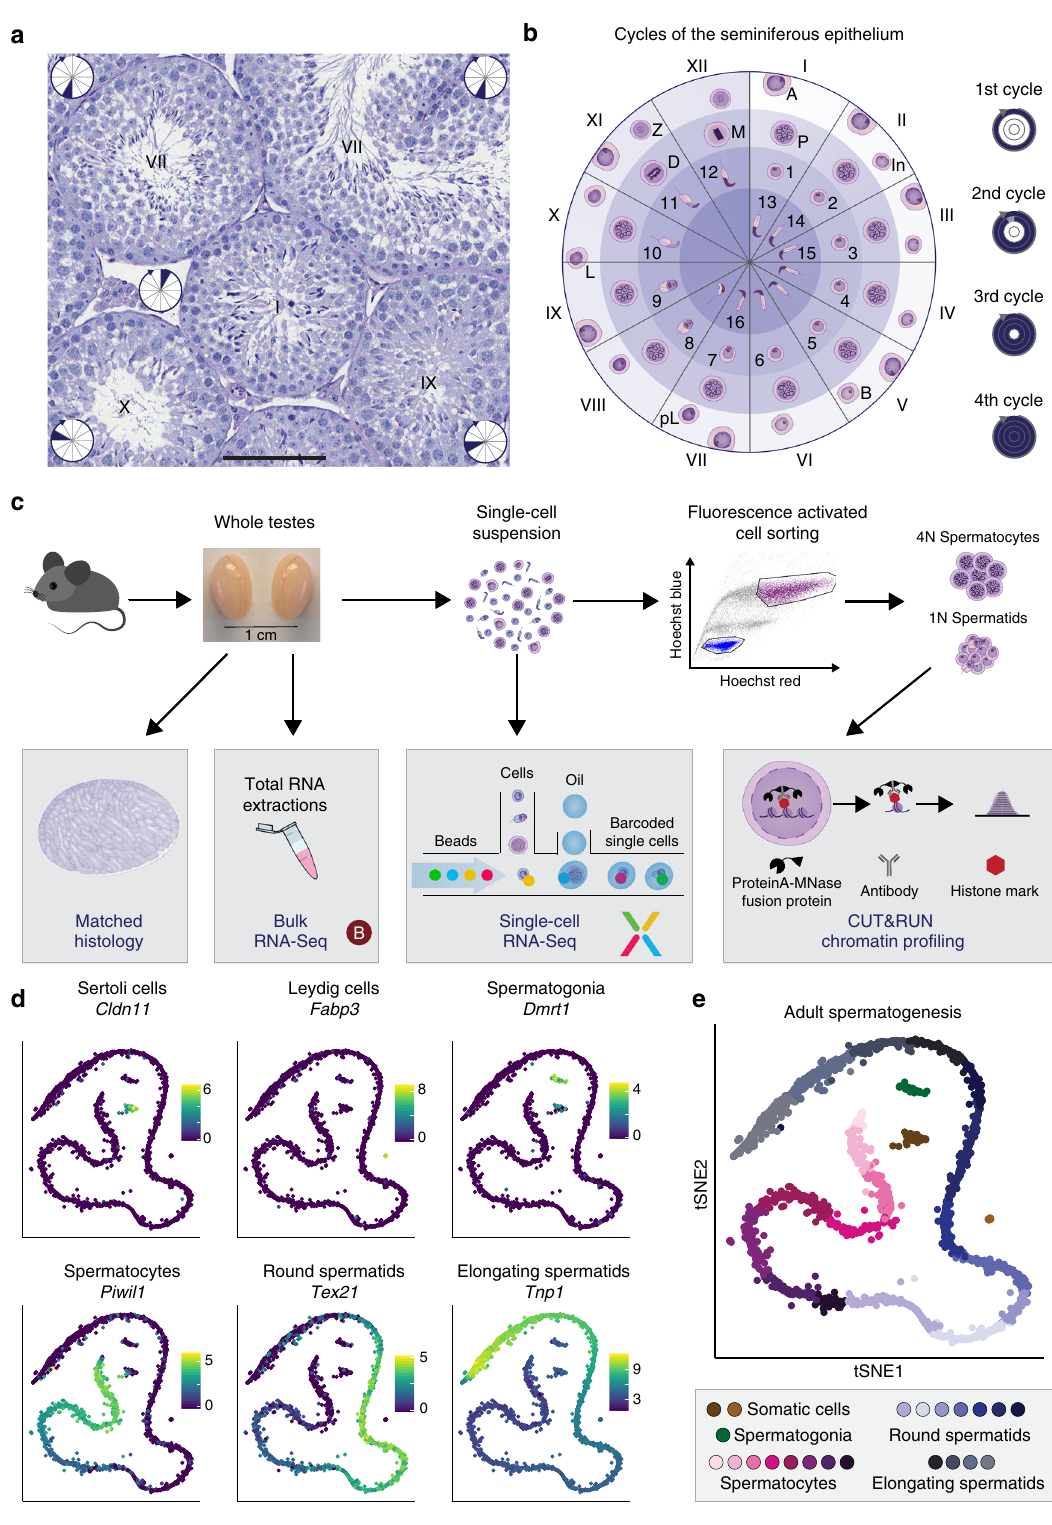
To further validate the identity of the cell clusters, we used bulk matched the bulk and scRNA-Seq data by using a probabilistic classi fi cation of the bulk samples based on cluster-speci fi c